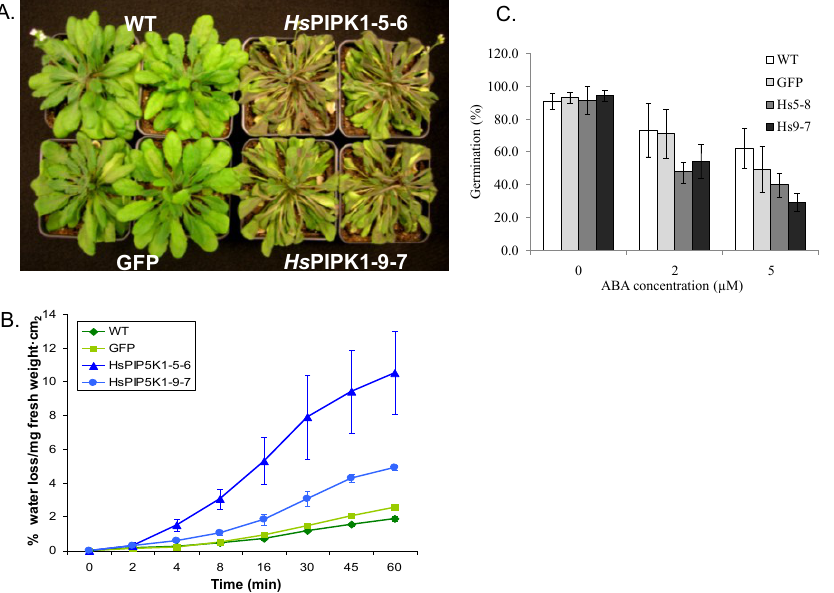
Figure 12. The Hs PIPKIα plants are drought sensitive and have increased water loss in the detached leaf assay. Plants were grown under a short day cycle (8 h of light/16 h of dark) at 21 °C with a light intensity of 150 µmol·m −2 ·s −1 in the North Carolina State University Phytotron in a growth chamber. ( A ) Water was withheld for 9 days and plants were photographed; ( B ) Detached leaves from well-watered plants were used to measure water loss over time; ( C ) The seeds from the Hs PIPKIα lines are more sensitive to ABA. The data are evaluated 3 days after seed germination on media containing different concentration of ABA. ~100 seeds per each concentration were tested in 3 independent experiments (Mean ±